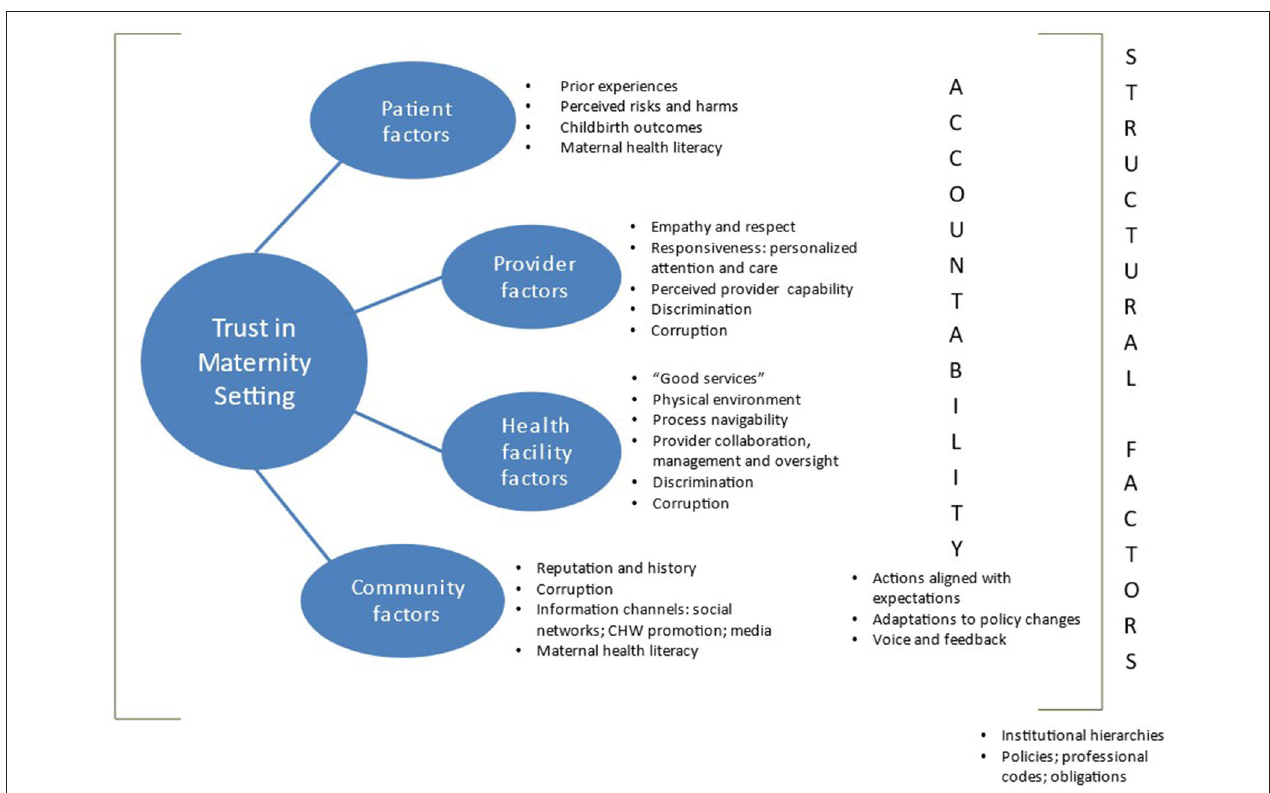
FIGURE 2 | Trust determinants framework in maternity